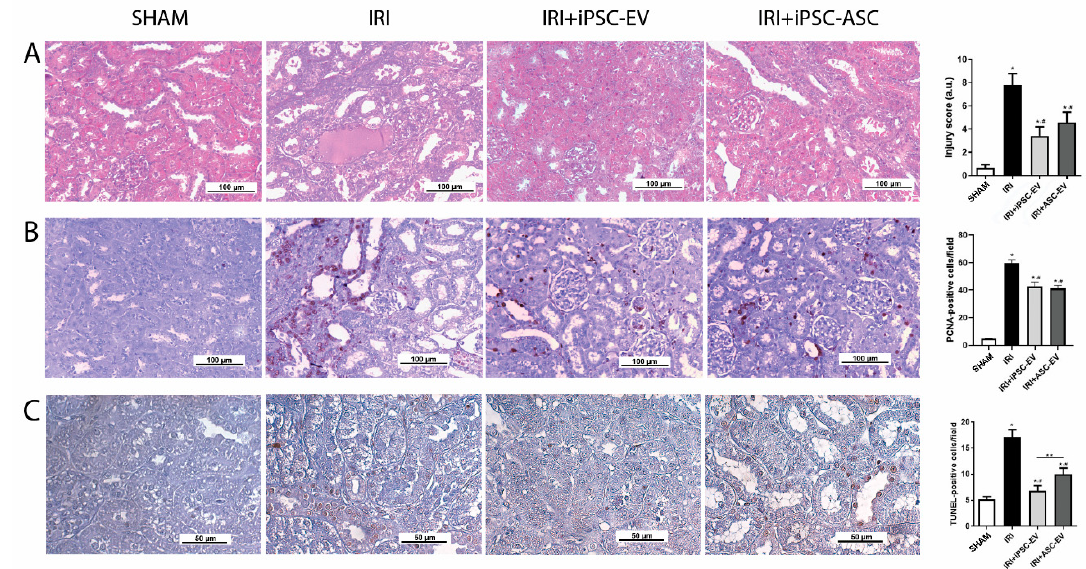
Figure 3. Subcapsular injection of iPSC-EV promoted the protection of renal tissue against ischemia- reperfusion injury (IRI). ( A ) Representative photomicrographs show the kidney cortical sections stained with hematoxylin / eosin (H / E) in the di ff erent experimental conditions (scale bar = 100 µ m). From the left image to the right: SHAM indicates false-operated animals; IRI represents the animals submitted to ischemia-reperfusion injury by the bilateral renal arterial clamping; IRI + iPSC-EV indicates the animals submitted to renal ischemia and that received subcapsular injection of iPSC-EV into the kidney just after the clamp release; IRI + ASC-EV indicates the animals submitted to renal ischemia and that received subcapsular injection of ASC-EV into the kidney just after the clamp release. The graph shows the score of tubular lesions in each condition. SHAM, n (kidneys) = 4; IRI, n (kidneys) = 8; IRI + iPSC-EV, n (kidneys) = 16; IRI + ASC-EV, n (kidneys) = 6. ( B ) Representative photomicrographs of immunohistochemistry for PCNA (scale bar = 100 µ m). The graph in the right shows the quantification of the number of PCNA-positive cells per field from immunohistochemistry. SHAM, n = 10 fields for 6 kidneys; IRI, n = 10 fields for 7 kidneys; IRI + iPSC-EV, n = 10 fields for 16 kidneys; IRI + ASC-EV, n = 10 fields for 6 kidneys. ( C ) Representative photomicrographs of immunohistochemistry for TUNEL (scale bar = 50 µ m). The graph in the right shows the quantification of the number of TUNEL-positive cells per field from immunohistochemistry. SHAM, n = 10 fields for 6 kidneys; IRI, n = 10 fields for 7 kidneys; IRI + iPSC-EV, n = 10 fields for 16 kidneys; IRI + ASC-EV, n = 10 fields for 6 kidneys. Data represent mean ± SEM (* indicates statistical di ff erence to SHAM group; # indicates statistical di ff erence to IRI group; ** indicates statistical di ff erence to IRI + iPSC-EV group; p < 0.05 assessed by one-way ANOVA followed by Tukey’s